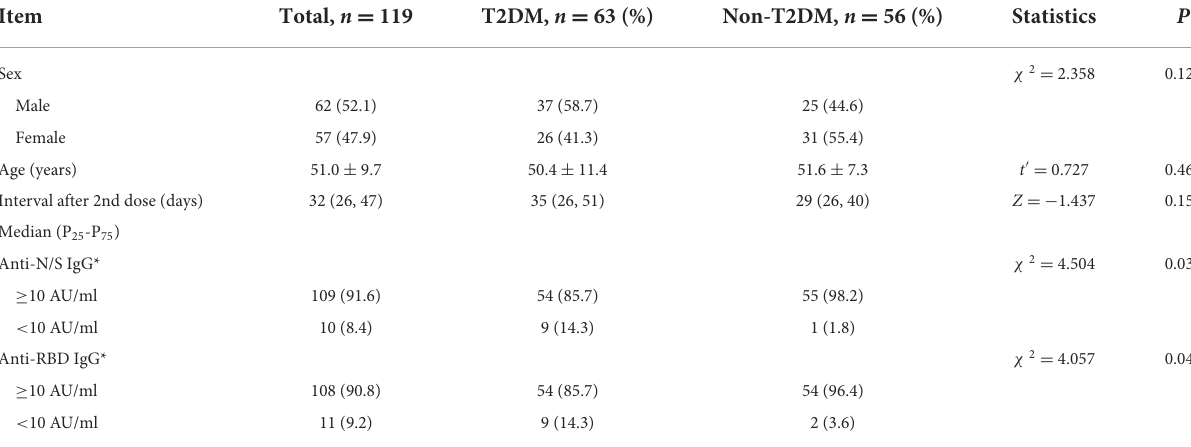
TABLE 1 Comparison of demographic characteristics and antibody response between T2DM and non-T2DM participants.